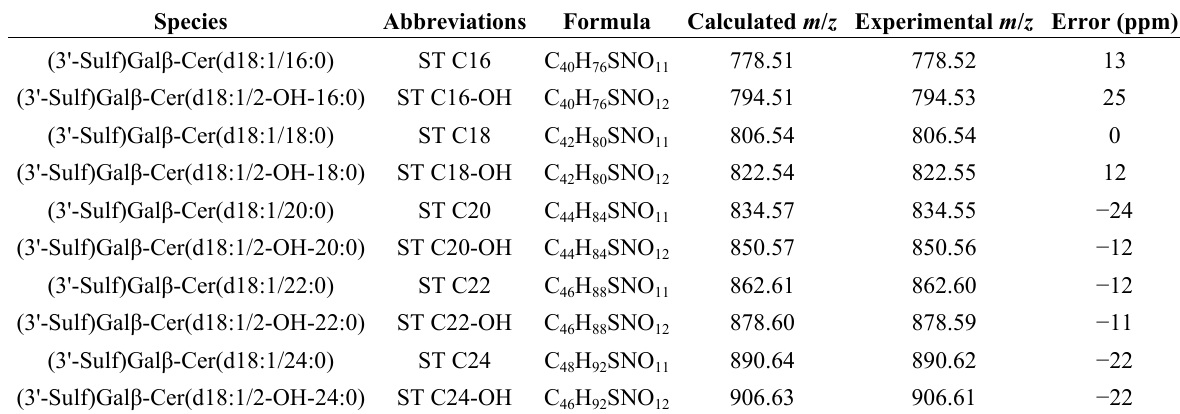
Table 1. Assignments of the compounds studied, including complete name, abbreviations, class and sub-class membership, formula, mass spectrometric diagnostic species, calculated and measured values of m / z and error in parts per million of the detected [M-H] − ion species.